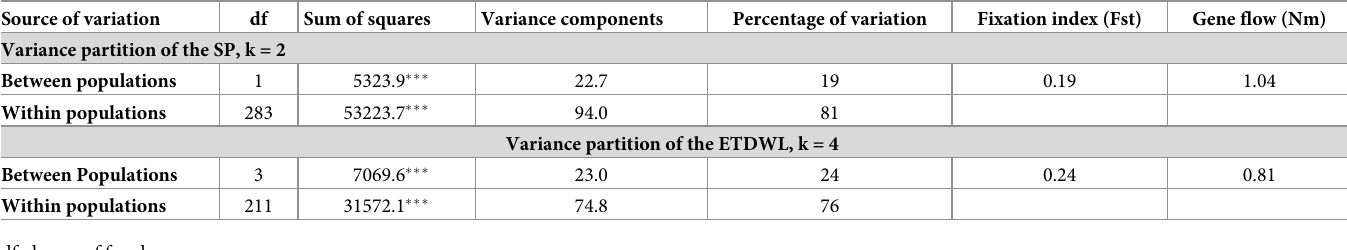
Table 1. AMOVA for the SP and ETDWL based on structure analysis